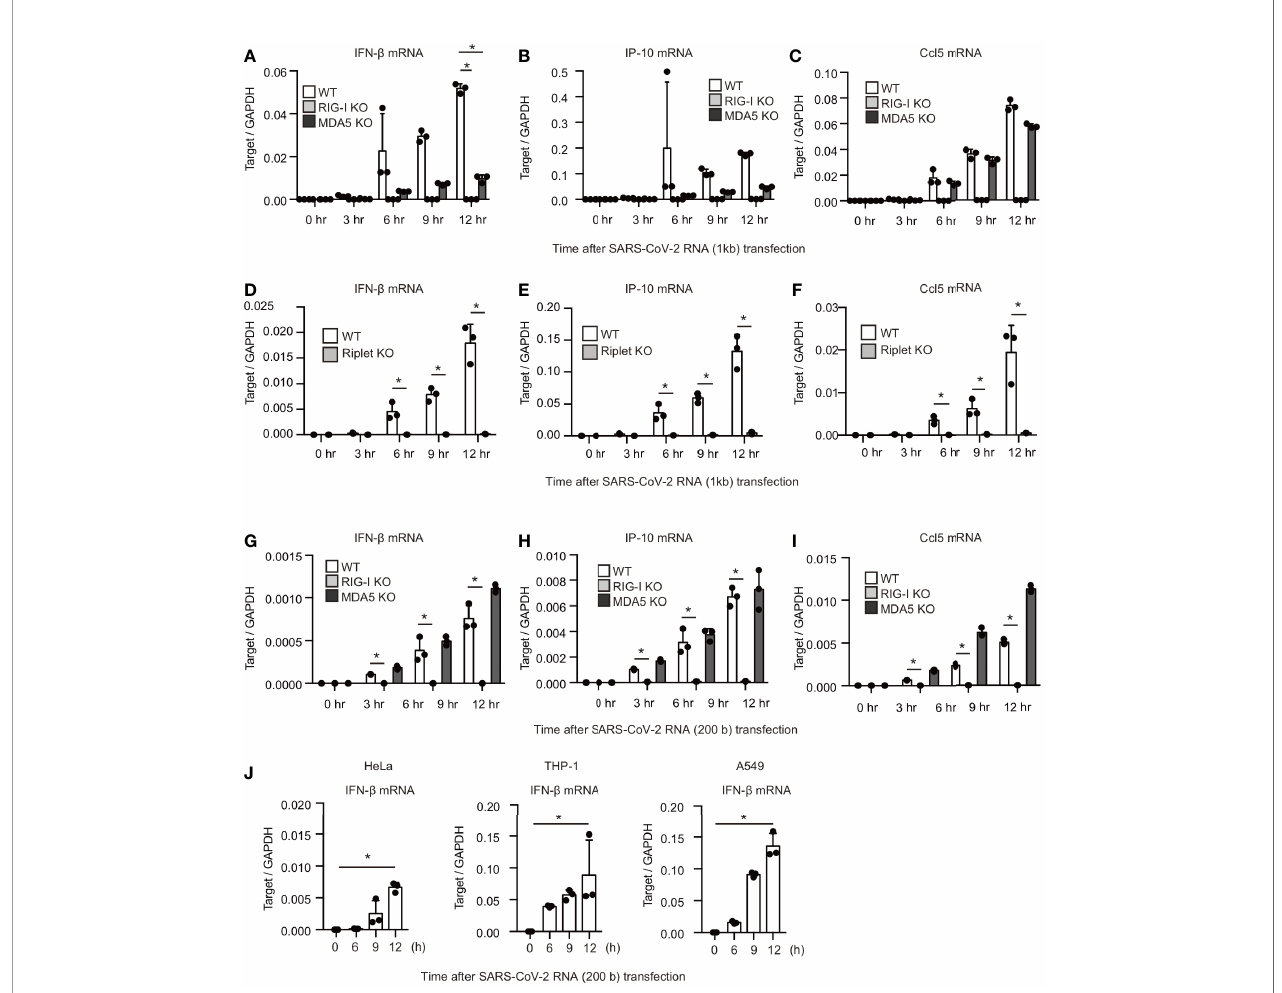
FIGURE 3 | RIG-I and MDA5 recognizes viral RNA fragment of SARS-CoV-2. (A – I) The viral RNA fragment containing 24001 – 25000 (A – F) or 24001 – 24200 region (G – I) was transfected into WT, RIG-I KO, MDA5 KO, and Riplet KO HEK293 cells, and then the expression of the cytokines was determined by RT-qPCR. The data represent the mean ± SD (n = 3, *p < 0.05, t-test). The data shown is representative of at least two independent experiments. (J) The viral RNA fragment containing 24001 – 24200 region was transfected into HeLa, A549, and THP-1 cells, and then expression of IFN- b was determined by RT-qPCR. The data represent the mean ± SD (n = 3, *p < 0.05, t-test). The data shown in representative of at least two independent